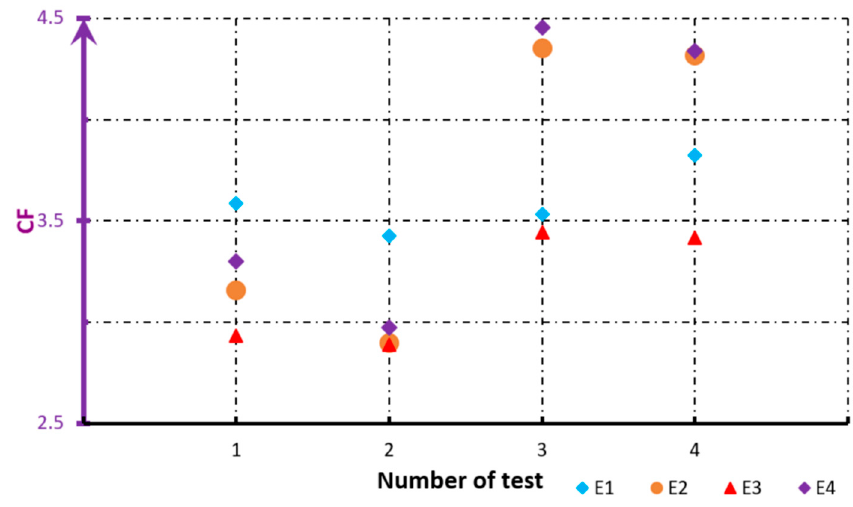
Figure 7. Chart of the crest factor (CF) change for the tests. Table 7. Determined average temperature increments of tested LED lighting